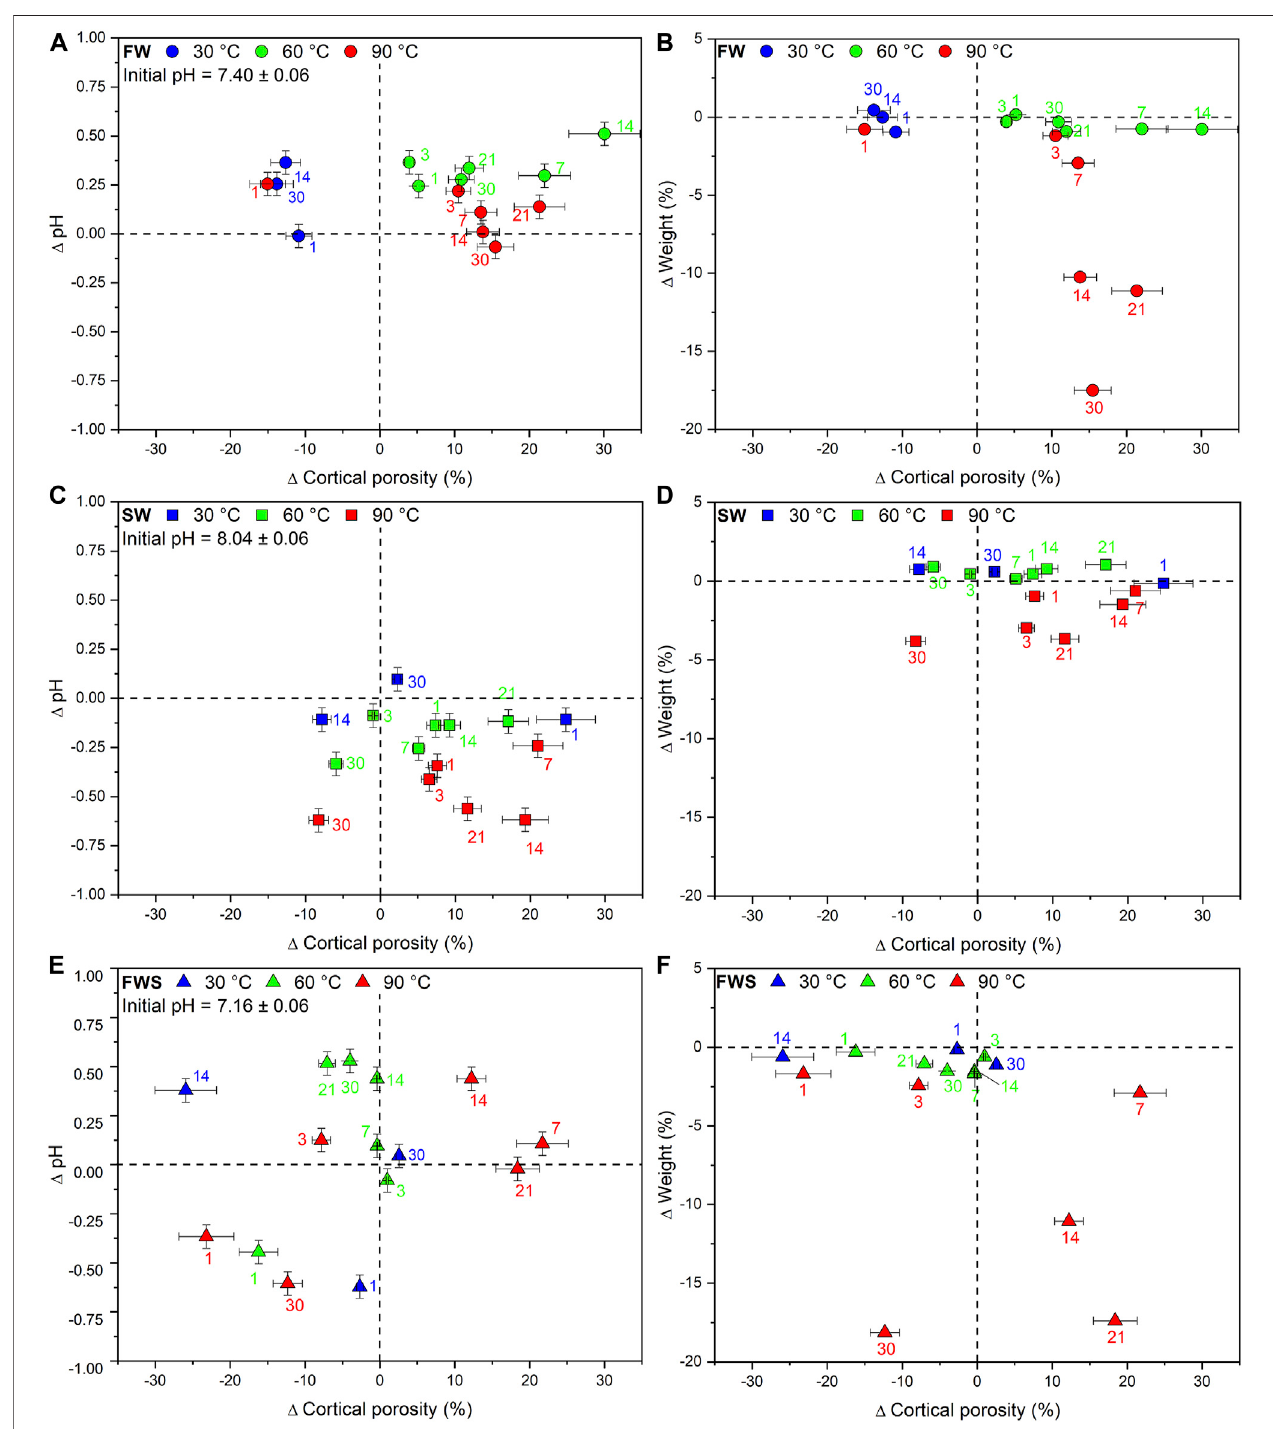
FIGURE 7 | Changes in cortical porosity observed during the experiments shown for each type of experimental solution (FW, SW, FWS) and temperature regime (30 ° C, 60 ° C, 90 ° C). (A, C, E) Difference in cortical porosity as a function of pH. (B, D, F) Difference in cortical porosity as a function of weight. Error bars represent the estimated 2-sigma standard deviation (see Table 5 ). Error bars of the weight loss data points are smaller than the symbols. The dashed reference lines represent the initial value of each data point.